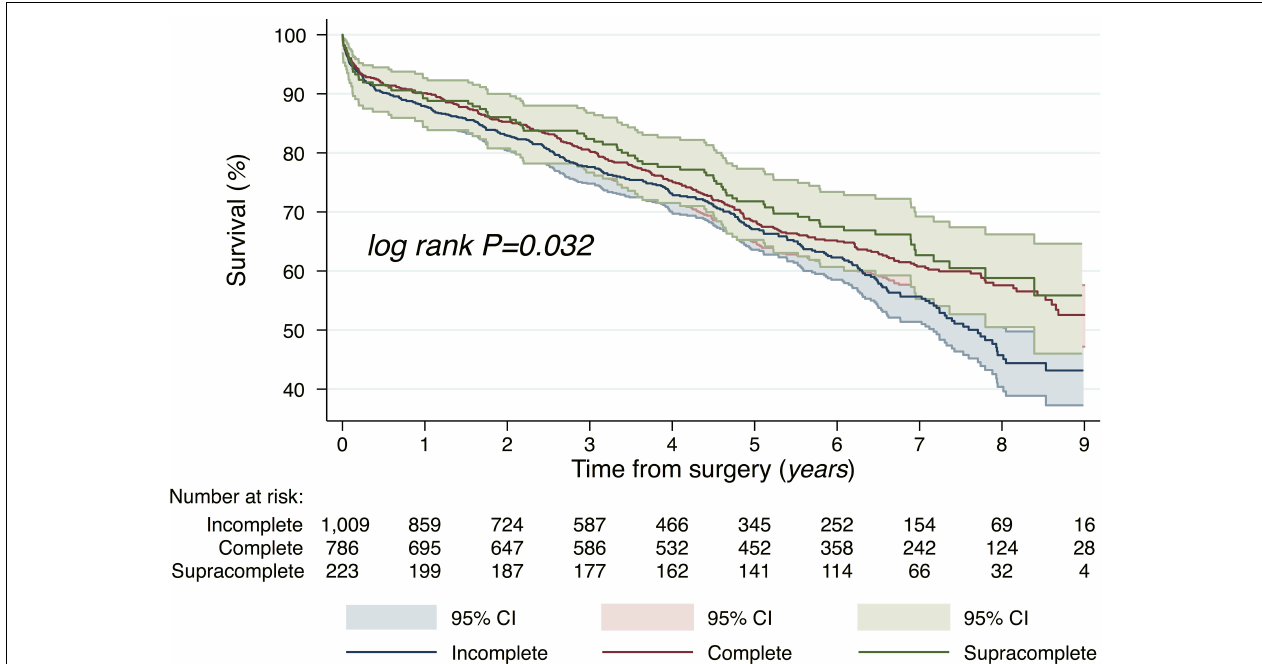
FIGURE 3 | Long-term mortality, propensity matched Kaplan–Meier survival curves between three groups: CR, non-CR, SCR CABG. Logrank test for differences in survival between groups. CR, complete revascularization; SCR, “supracomplete” revascularization.